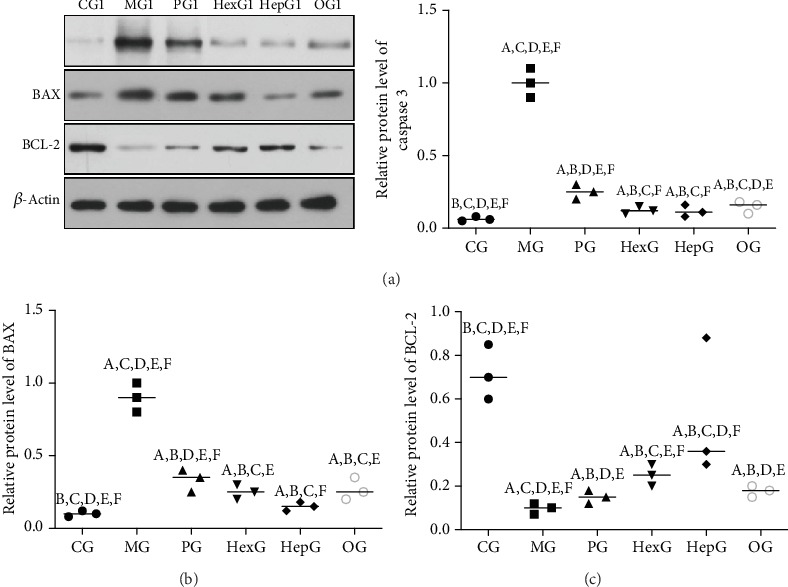
Relative protein levels of apoptotic factors among different groups. (a) Caspase 3. (b) BCL-2-associated X protein (BAX). (c) B cell lymphoma 2 (BCL-2). CG: control group: MG: model group: PG: chitopentaose-treated group: HexG: chitohexaose-treated group: HepG: chitoheptaose-treated group: OG: chitooctaose-treated group. n = 3 for each group. Ap < 0.05 vs. the CG group, Bp < 0.05 vs. the MG group, Cp < 0.05 vs. the PG group, Dp < 0.05 vs. the HexG group, Ep < 0.05 vs. the HepG group, and Fp < 0.05 vs. the OG group. Three samples were measured from each group with the numbers 1, 2, and 3. Supplementary Figure S2 showed Western blot analysis of the samples 2 and 3 from each group.